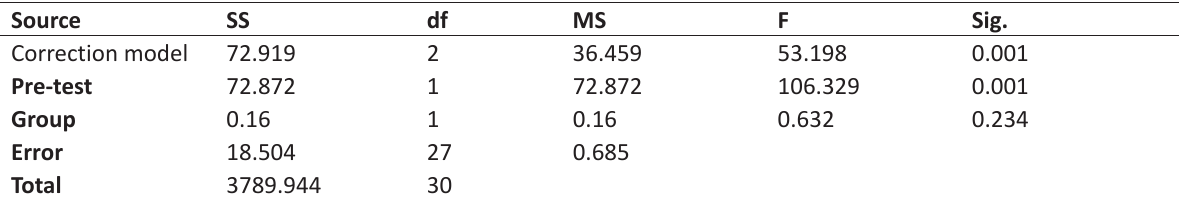
Table 3. Results of the covariance analysis test to examine the effect of two educational methods on basketball dribbling skill